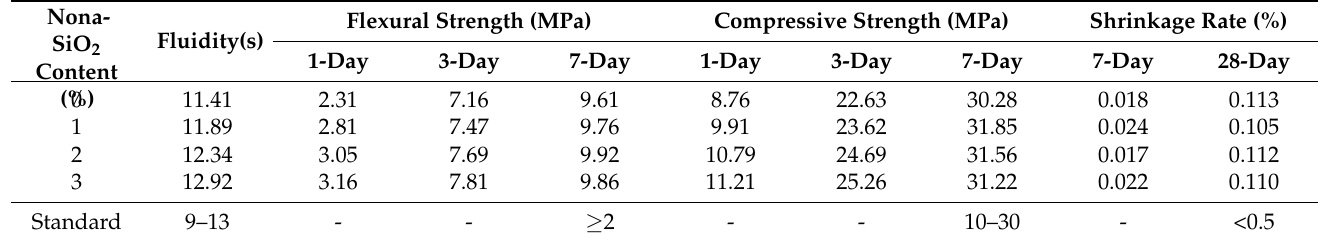
Table 4. The performance of cement grouting materials with different nano-SiO 2